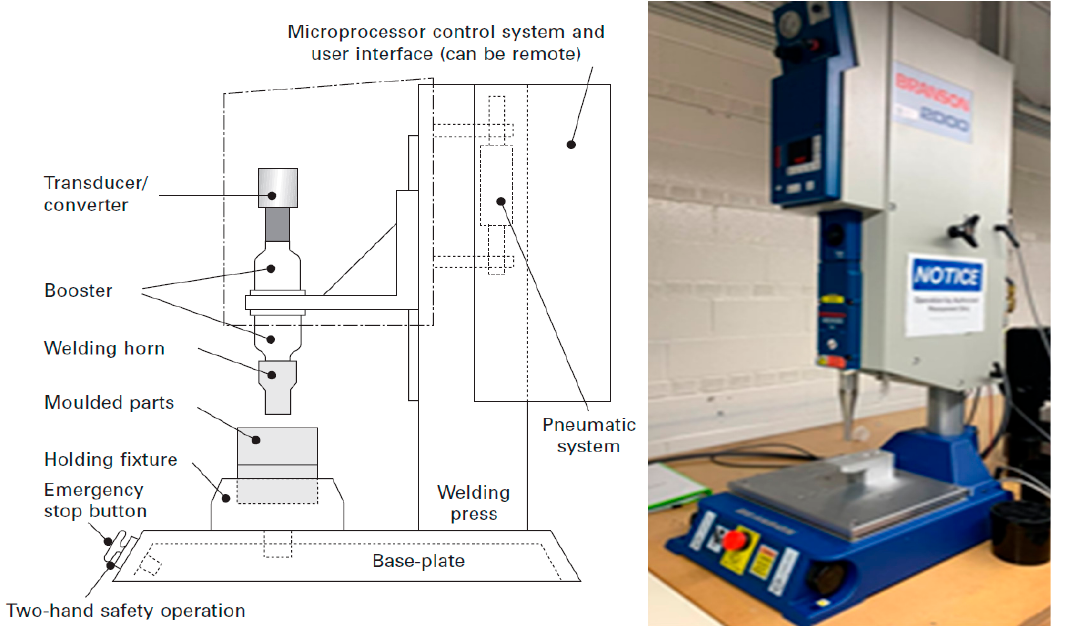
Figure 2. Schematic of the ultrasonic welding machine, displaying its key features [9] ( left ); Photograph of the ultrasonic welding machine ( right ).